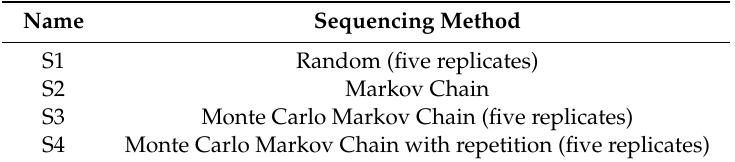
Table 4. Simulated sequencing methods.